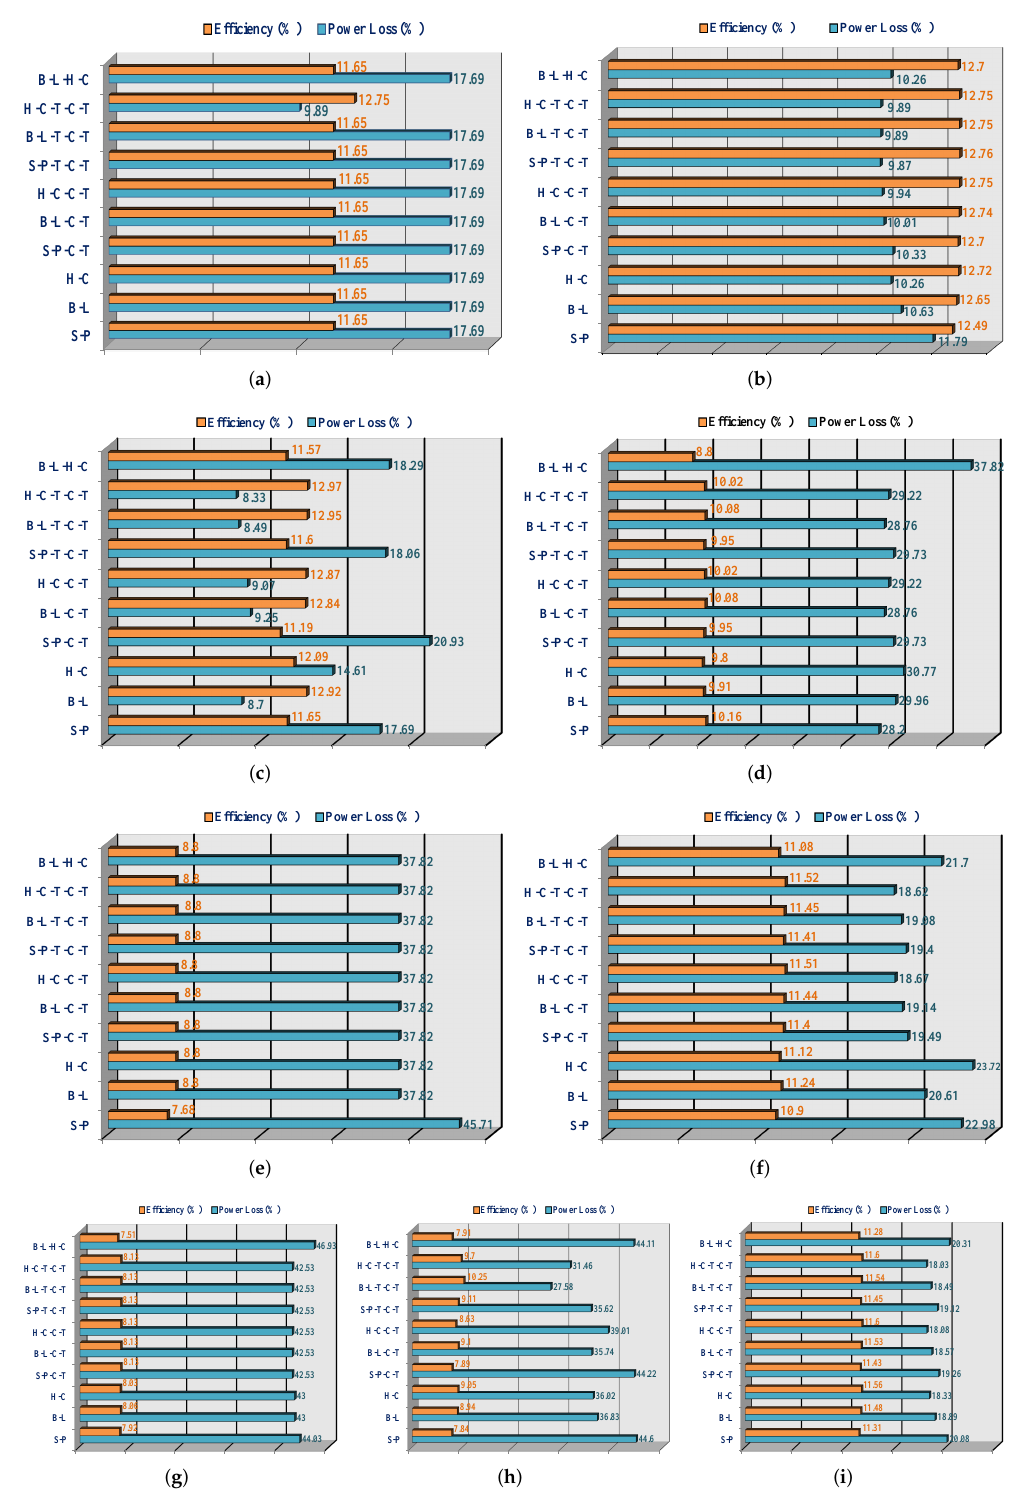
Figure 15. Efficiency and mismatching power losses of conventional and proposed hybrid topologies under various shading patterns: ( a ) uneven-row, ( b ) uneven-column, ( c ) diagonal, ( d ) SAN, ( e ) SAW, ( f ) LAN, ( g ) LAW, ( h ) random, and ( i )